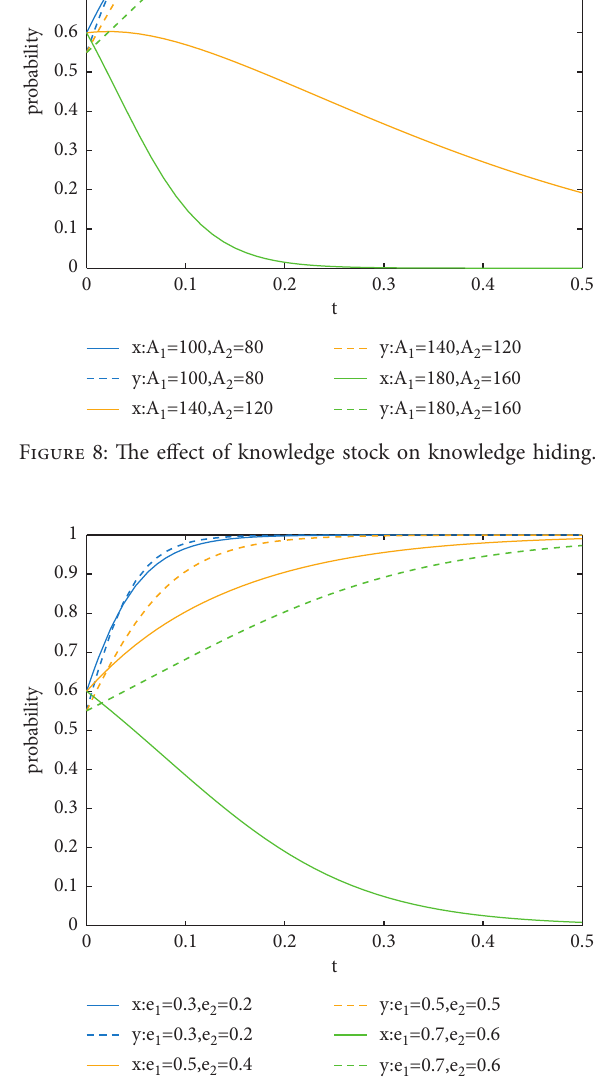
Figure 9: The effect of incentive level for cooperation on knowledge